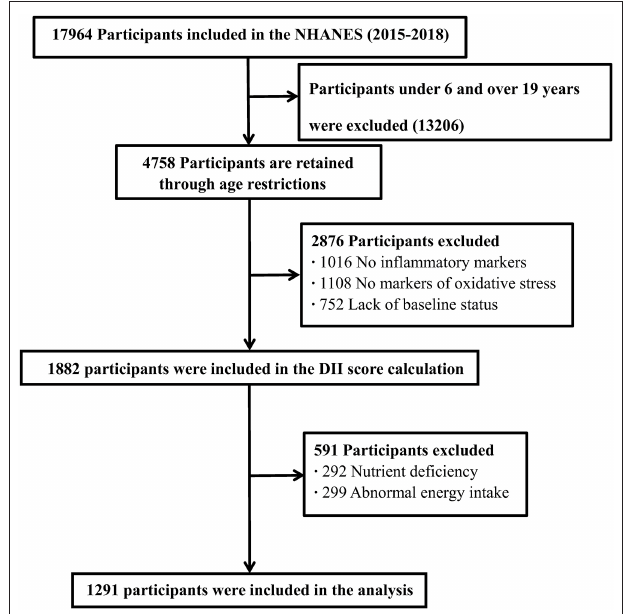
FIGURE 1 | Flow diagram of analytic samples from NHANES